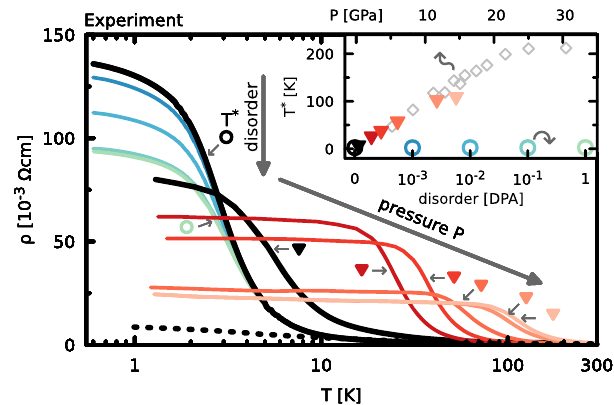
Fig. 1 Resistivity saturation in Ce 3 Bi 4 Pt 3 . Below an in fl ection temperature T * (indicated by small arrows), experimental resistivities ρ ( T ) 5 – 7 deviate from activation-like behavior ( T > T *) and enter a regime of resistivity saturation ( T < T *). Pressure and disorder affect the resistivity differently: under pressure (black and shades of red; from Cooley et al. 5 ) the crossover temperature T * (labeled with colored triangles and reported in the inset) grows signi fi cantly and the saturation value ρ ( T → 0) decreases. Radiation- induced disorder (black and blue to green; from Wakeham et al. 6 ) only suppresses ρ ( T → 0), while T * (labeled with colored circles and reported in the inset) remains constant. Also shown are results at ambient pressure from Katoh et al. 57 (dashed black line). Differences between black curves (solid and dashed) demonstrate a strong sample dependence. Inset: dependence of T * on pressure (upper x axis; red-shaded triangles 5 , gray diamonds from Campbell et al. 7 ) and disorder (measured in displacements per atom (DPA); lower x axis; blue to green open circles 6